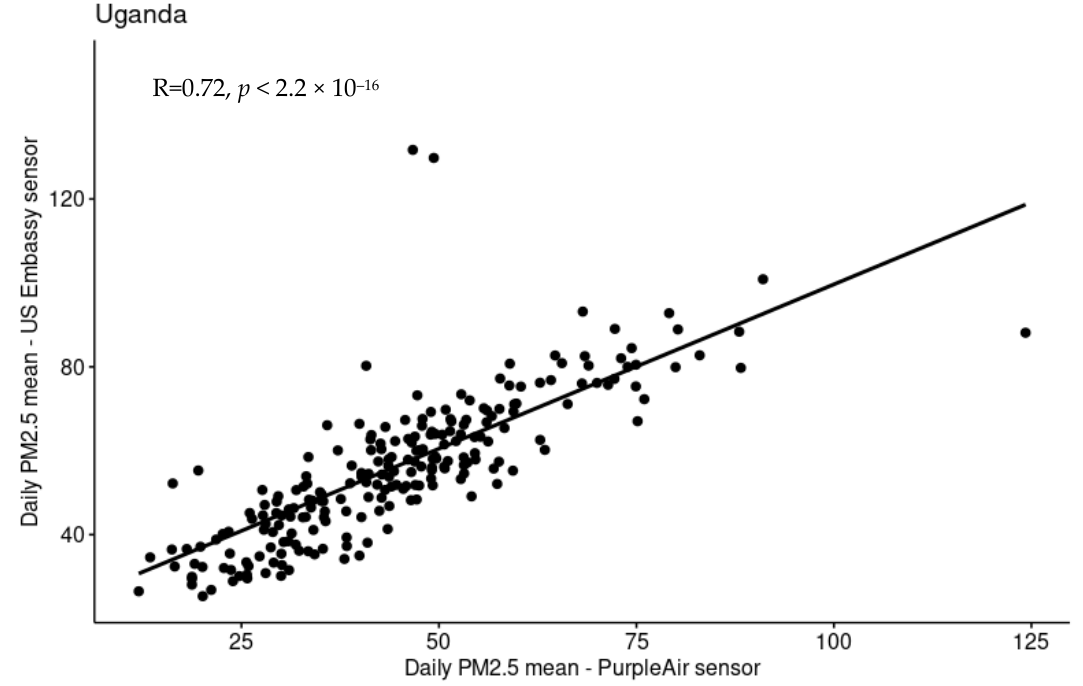
R=0.72, p < 2.2 × 10 –16